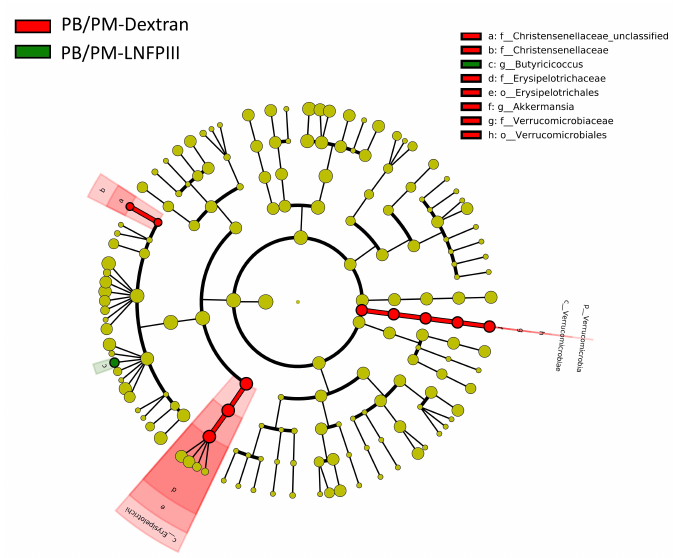
Figure 5. Linear discriminant analysis (LDA) e ff ect size (LEfSe; Kruskall–Wallis ( p < 0.05); Pairwise Wilcoxon ( p < 0.05); logarithmic LDA score > 2.0) of the fecal microbiota of PB / PM-Dextran or PB / PM-LNFPIII mice collected 9 months after GWI exposures. Taxa with increased sequence abundances in either PB / PM-Dextran (Red) or PB / PM-LNFPIII (Green) are marked. Taxonomic rank labels are provided before bacterial names: “p_; c_; o_; f_; g_” indicate phylum, class, order, family, and genus, respectively. Letters within the cladogram refer to bacterial names located in the key to the